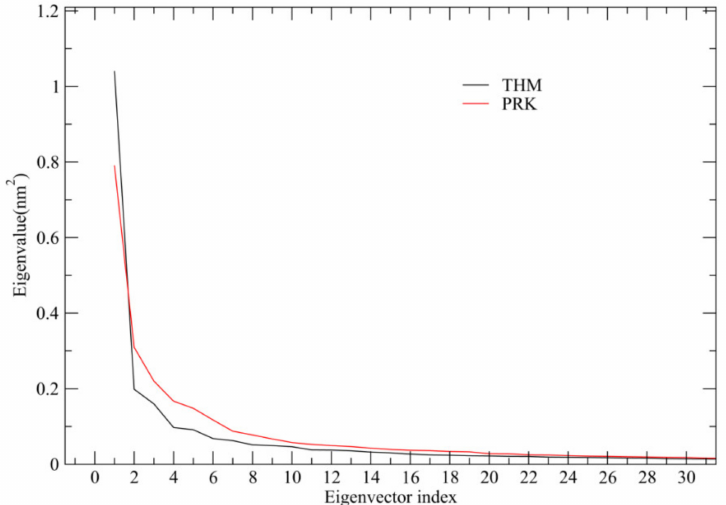
Figure 4. Eigenvalues as a function of the eigenvector index. Only those of the first 30 eigenvectors are